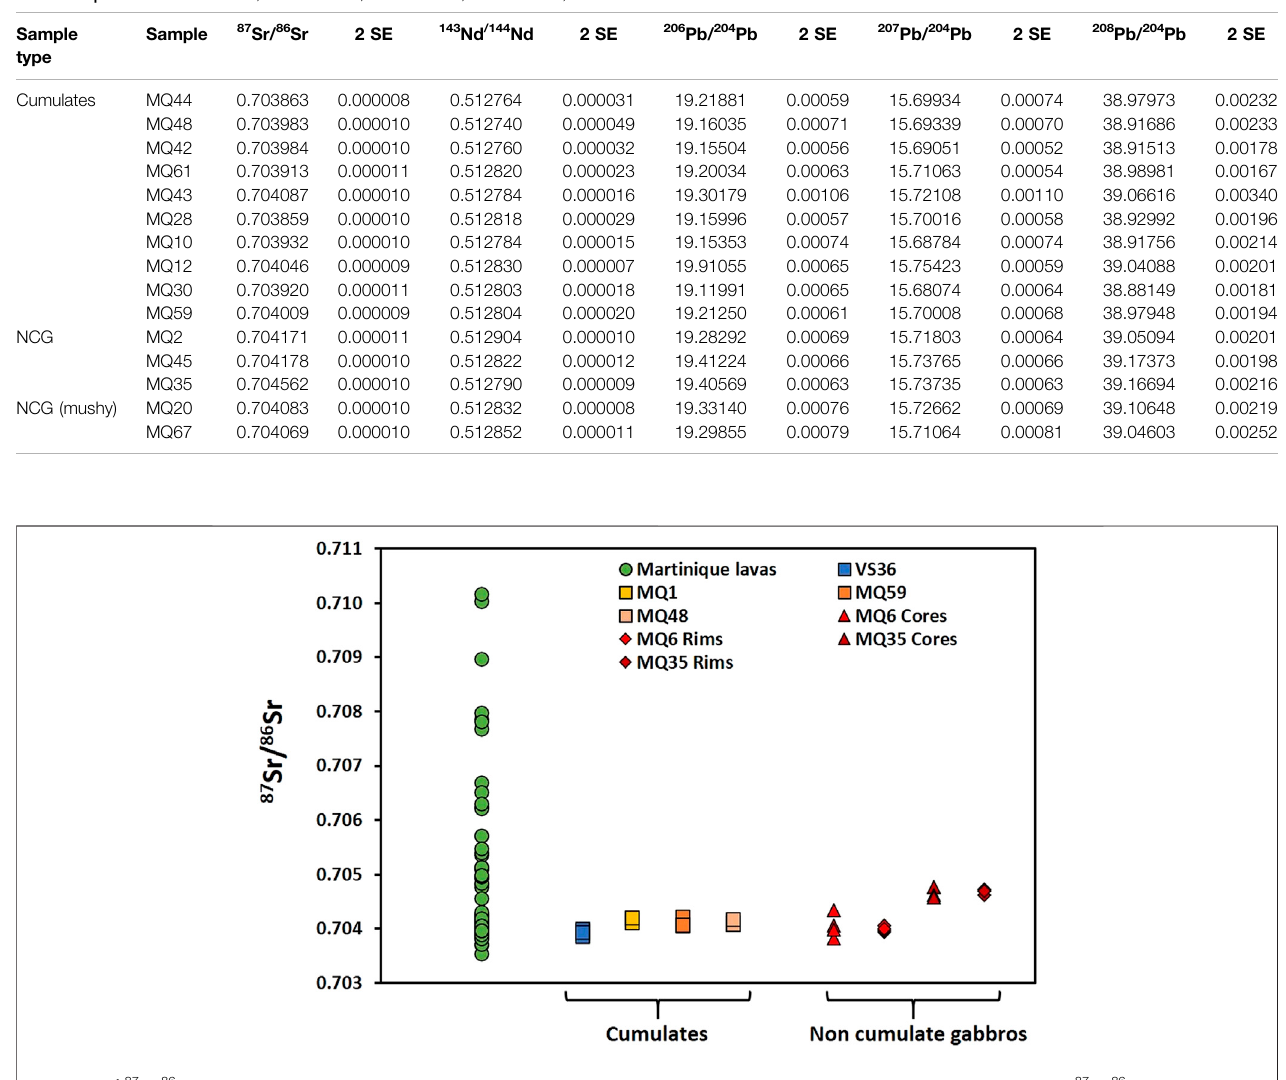
Frontiers in Earth Science |